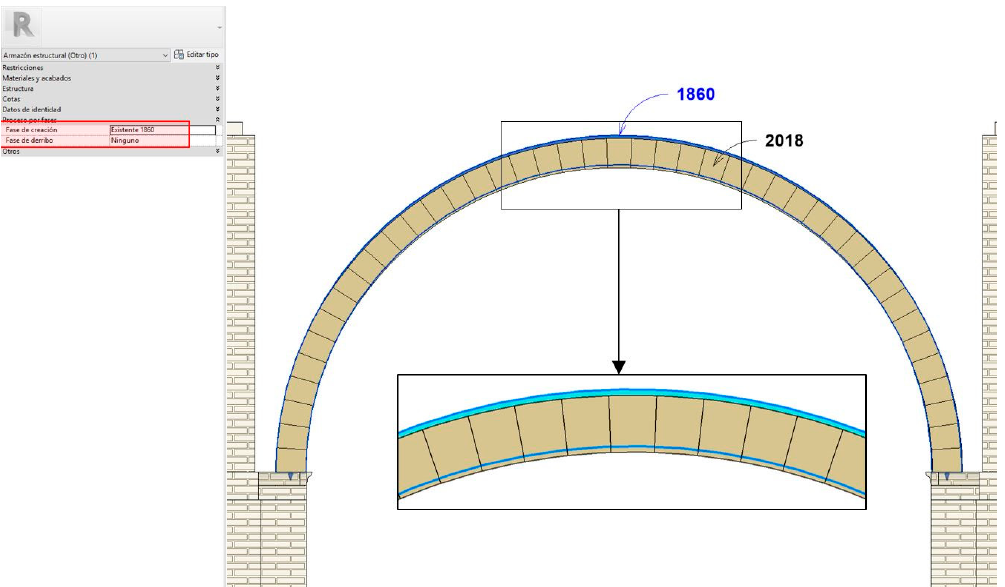
Figure 12. Use of the execution phases to register the central arch in 1860 and 2018.